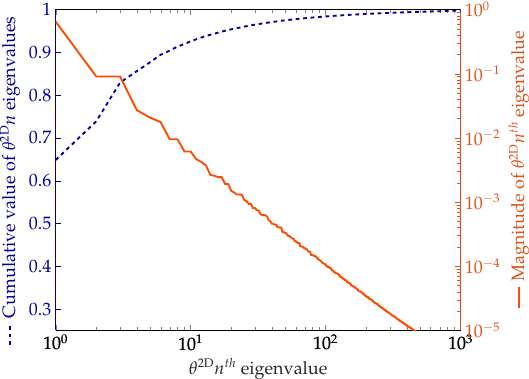
Figure 22. Magnitude of the eigenvalues and their cumulative sum for model problem